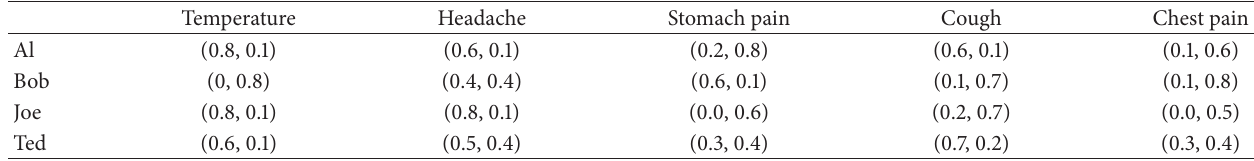
Table 3: Symptoms characteristic for the patients.